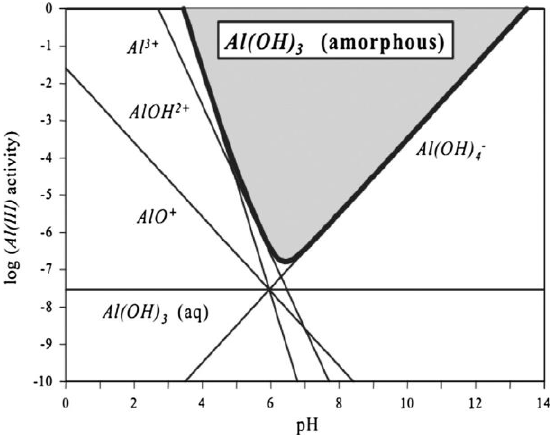
Figure 7. Activity–pH diagram for Al 3+ species with Al (OH)